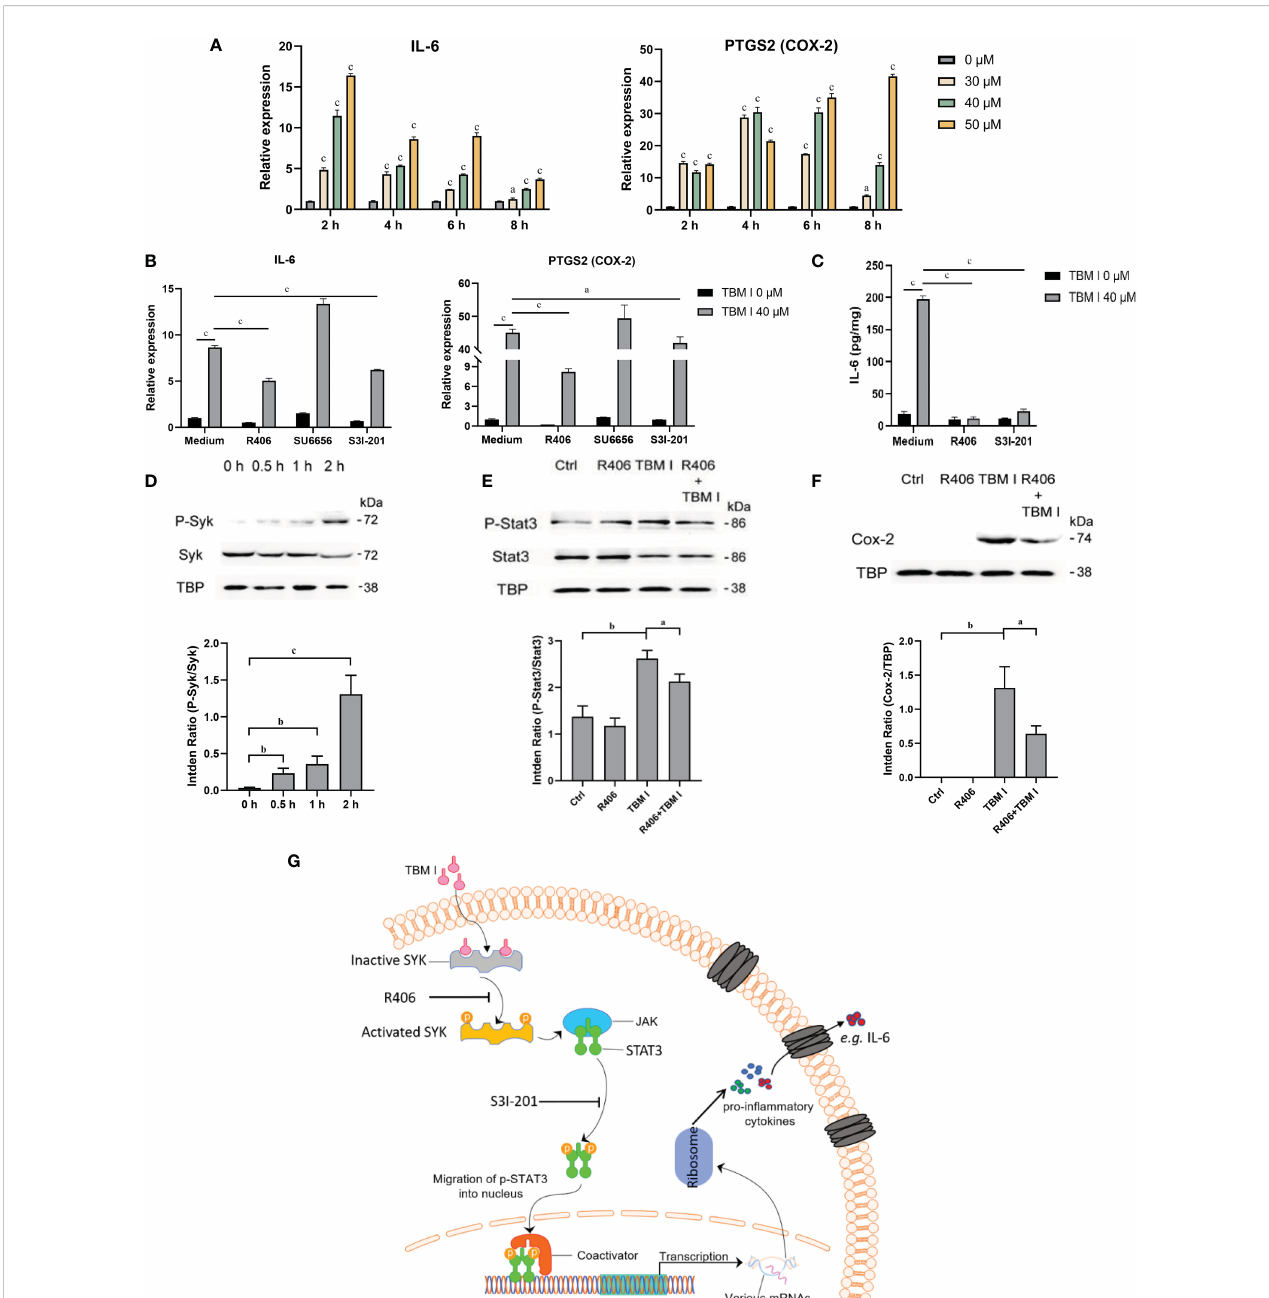
FIGURE 9 SYK-STAT3 pathway contributed the in fl ammatory response in C2C12 cells induced by TBM I. (A) The gene expression of IL-6 and PTGS2 in C2C12 cells induced by TBM I with RT-qPCR. (B) C2C12 cells were pretreated with SYK inhibitor (R406, 8 µM, 1 h), LYN inhibitor (SU6656, 2 m M, 1 h) or STAT3 inhibitor (S3I-201, 100 m M, 1 h) before TBM I (40 µM) stimulation for 4 h. The gene expression levels of IL-6 and PTGS2 in C2C12 cells were determined by RT-qPCR. (C) After pre-incubation with or without R406 (8 µM, 1 h) or S3I-201 (100 m M, 1 h), C2C12 cells were treated with medium or TBM I (40 m M) for 12 h. The level of IL-6 in the culture supernatants of C2C12 cells by ELISA. (D) C2C12 cells were treated with TBM I (40 m M) for 0, 0.5, 1, and 2 h, and the protein levels of P-Syk/SyK levels were detected by Western blotting. (E) , (F) After pre-incubation with or without R406 (8 µM, 1 h), C2C12 cells were treated with medium or TBM I (40 m M) for 4 h or 8 h, and the protein levels of P-Stat3/Stat3 (E) and COX-2 (F) were detected by Western blotting. The fi gure shown was representative of three independent experiments. Data were presented as mean ± SD ( n = 3). a P < 0.05, b P < 0.01, and c P < 0.001. (G) Hypothetical pathway involving in the in fl ammatory response in C2C12 cells induced by TBM